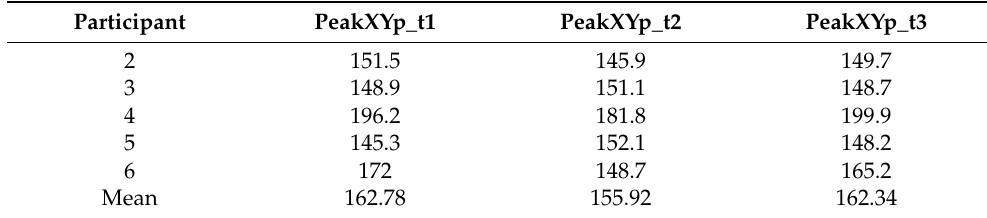
Table 25. PeakXY, pudding 10 mL (%C2–4) individual and mean measurements at three assessment time